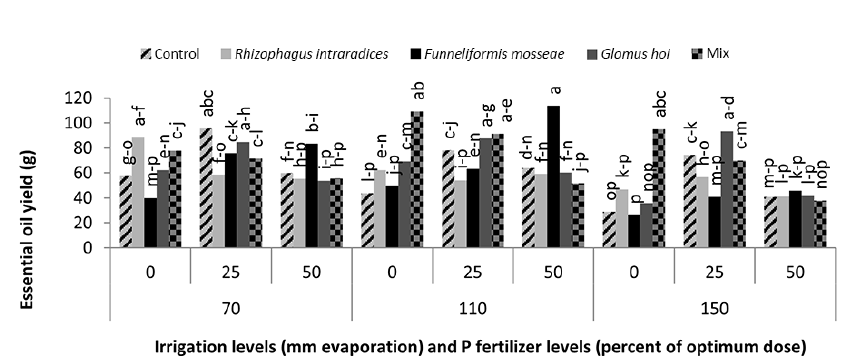
Figure 12 Effect of arbuscular mycorrhization and P fertilizer levels under different irrigation regimes on essential oil yield of